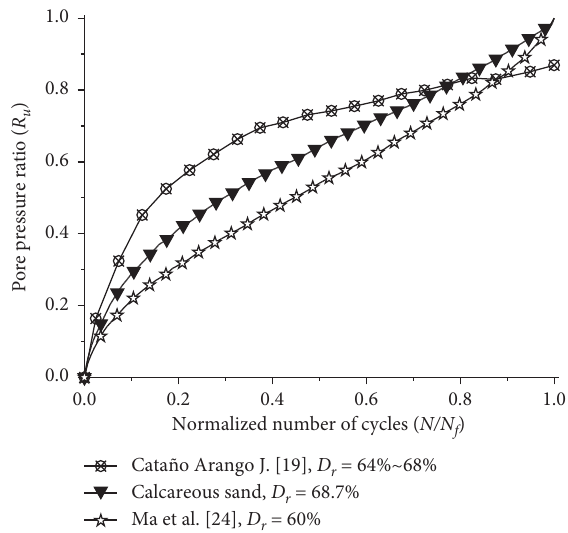
Figure 15: Comparison between the test data and predicted values of excess pore pressure of calcareous sand [24,